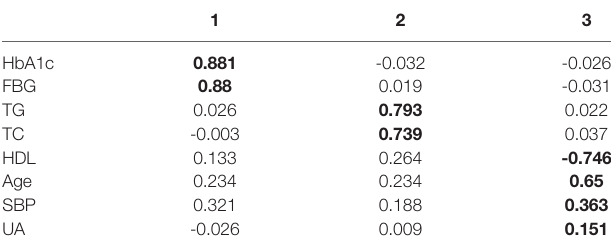
TABLE 6 | LCA-derived HRF clusters.